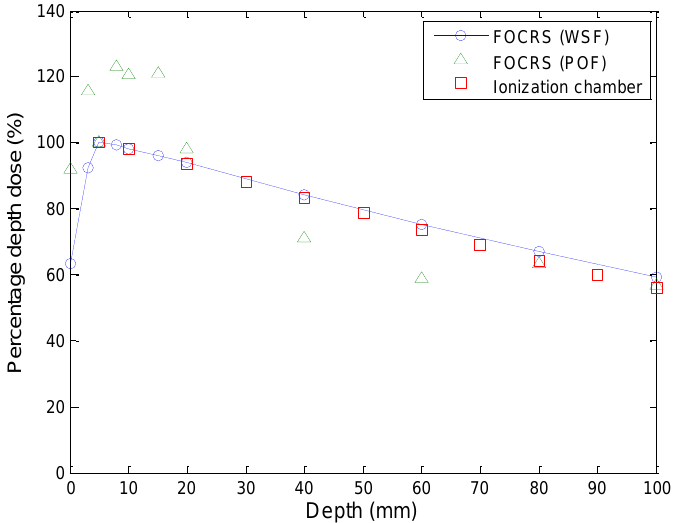
Figure 11. Measured percentage depth doses according to depths of water phantom using